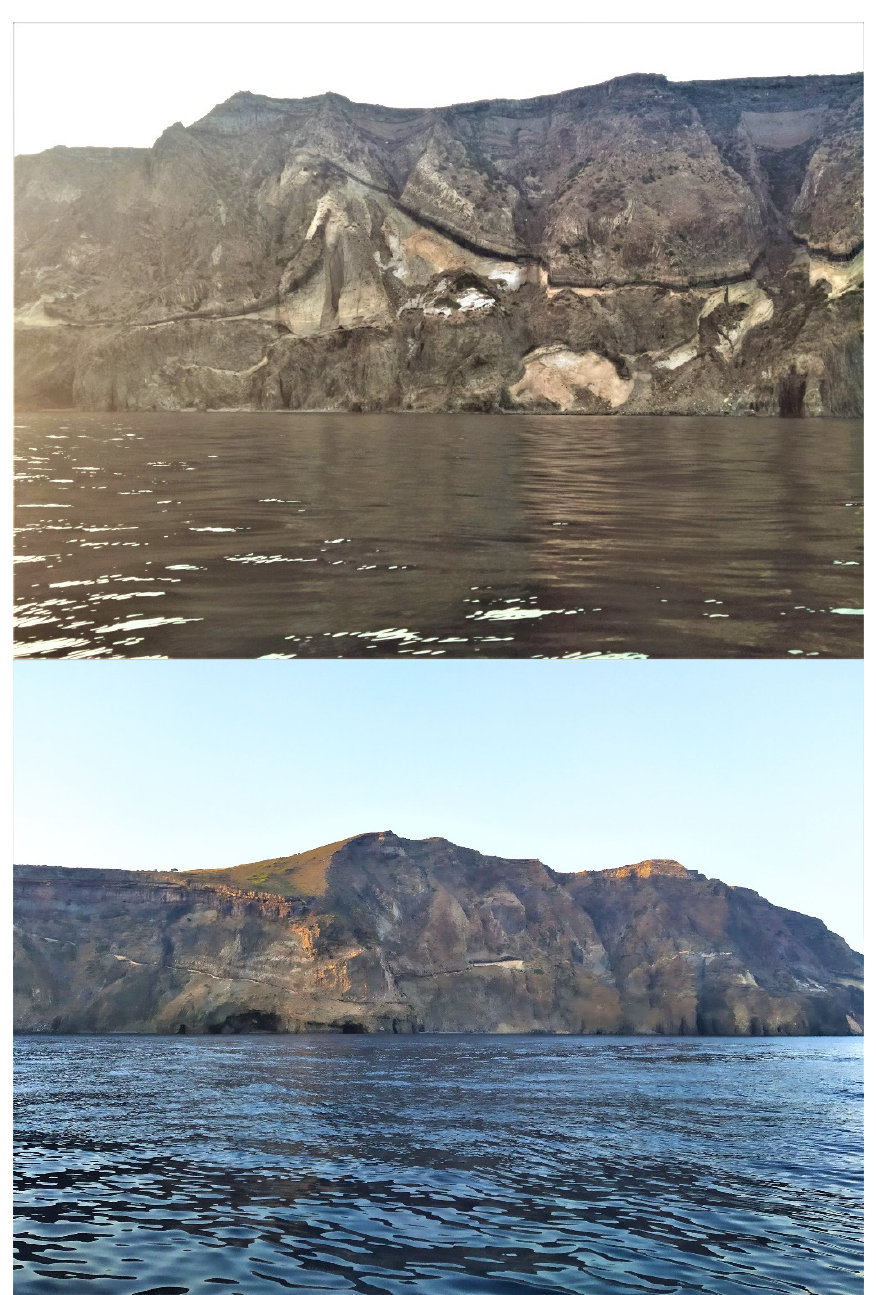
Figure 13. Two aspects from the sea of Punta Limarsi (Pantelleria Is., Sicily), where the newly discovered Acheta lives.